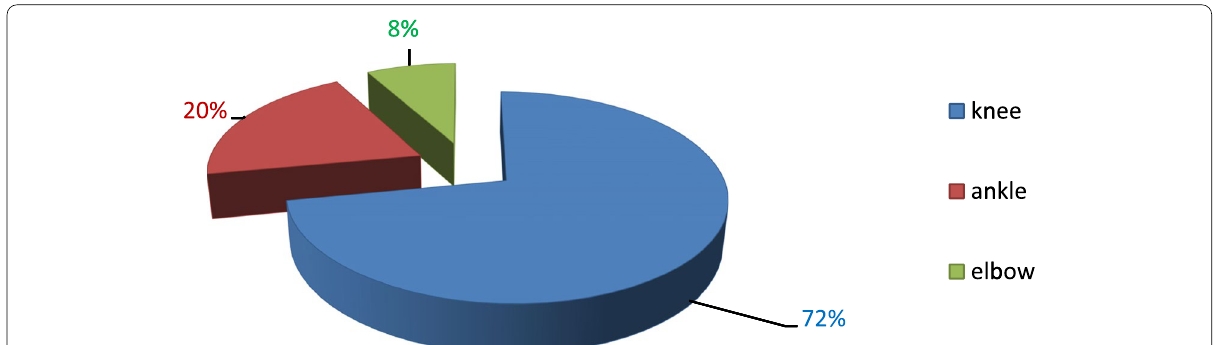
Fig. 1 Distribution of hemophilic patients according to the most affected and/or the target joint